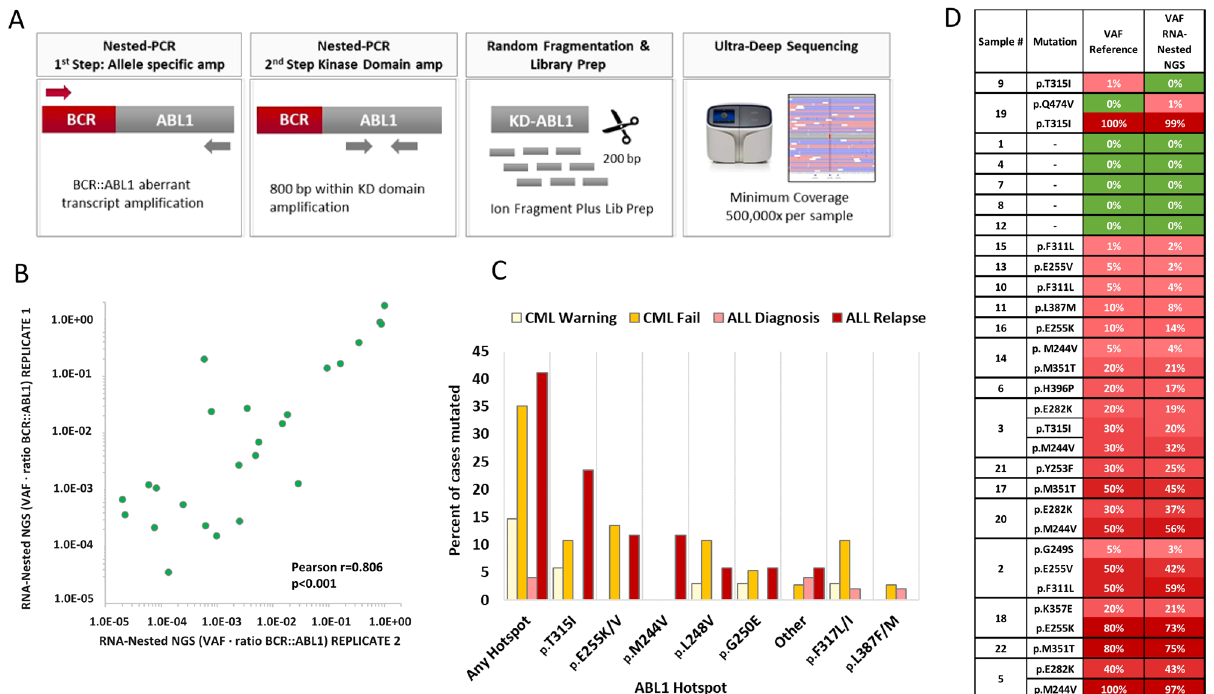
Figure 2. ( A ) Scheme methodology of the detection of BCR::ABL1 mutations by RNA-NestedNGS; ( B ) Correlation between the two replicates by RNA-NestedNGS; ( C ) Histogram of mutational frequency by RNA-NestedNGS method in failure/warning stages for CML patients and diagnosis/relapse ALL patients; ( D ) Results from EUTOS international control round for deep sequencing analysis of BCR::ABL1 mutations using RNA-NestedNGS approach showing the ability of the nested method to detect KD mutations. ALL acute lymphoblastic leukemia, CML chronic myeloid leukemia, KD kinase